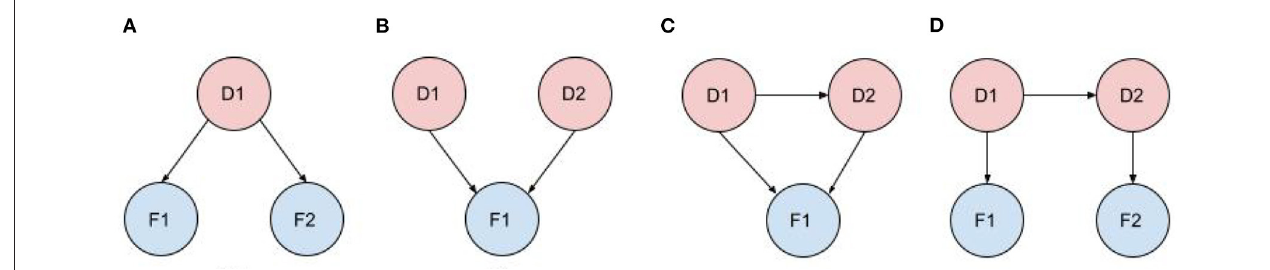
FIGURE 2 | Typical diagnostic BN configurations. (A) A disorder causes 2 findings; (B) Independent disorders both cause a finding; (C) Causally related disorders cause the same finding; (D) Causally related disorders each explain a subset of the patient